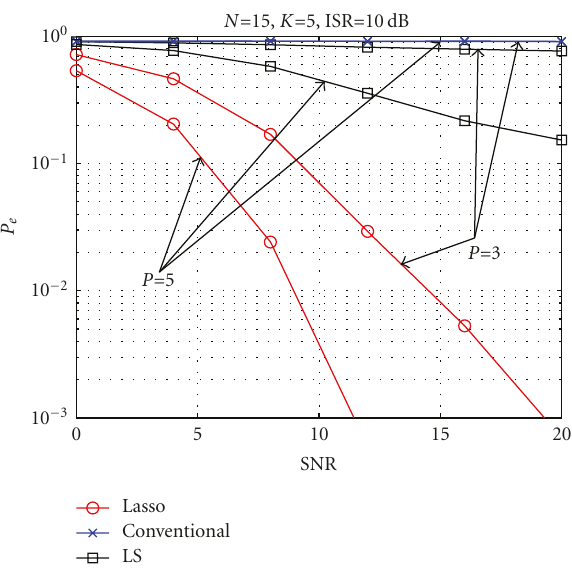
Figure 2: Probability of incorrect delay estimation versus SNR in a near-far scenario (chip-synchronous system with AWGN and known K